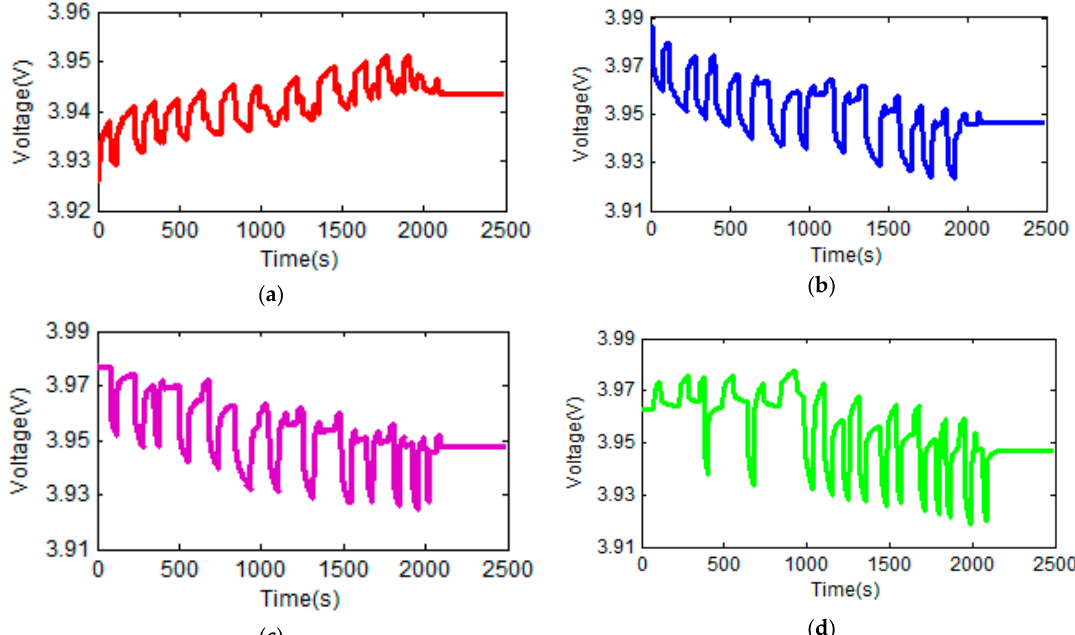
Figure 9. Four cells’ voltage waveforms in the equalization process.